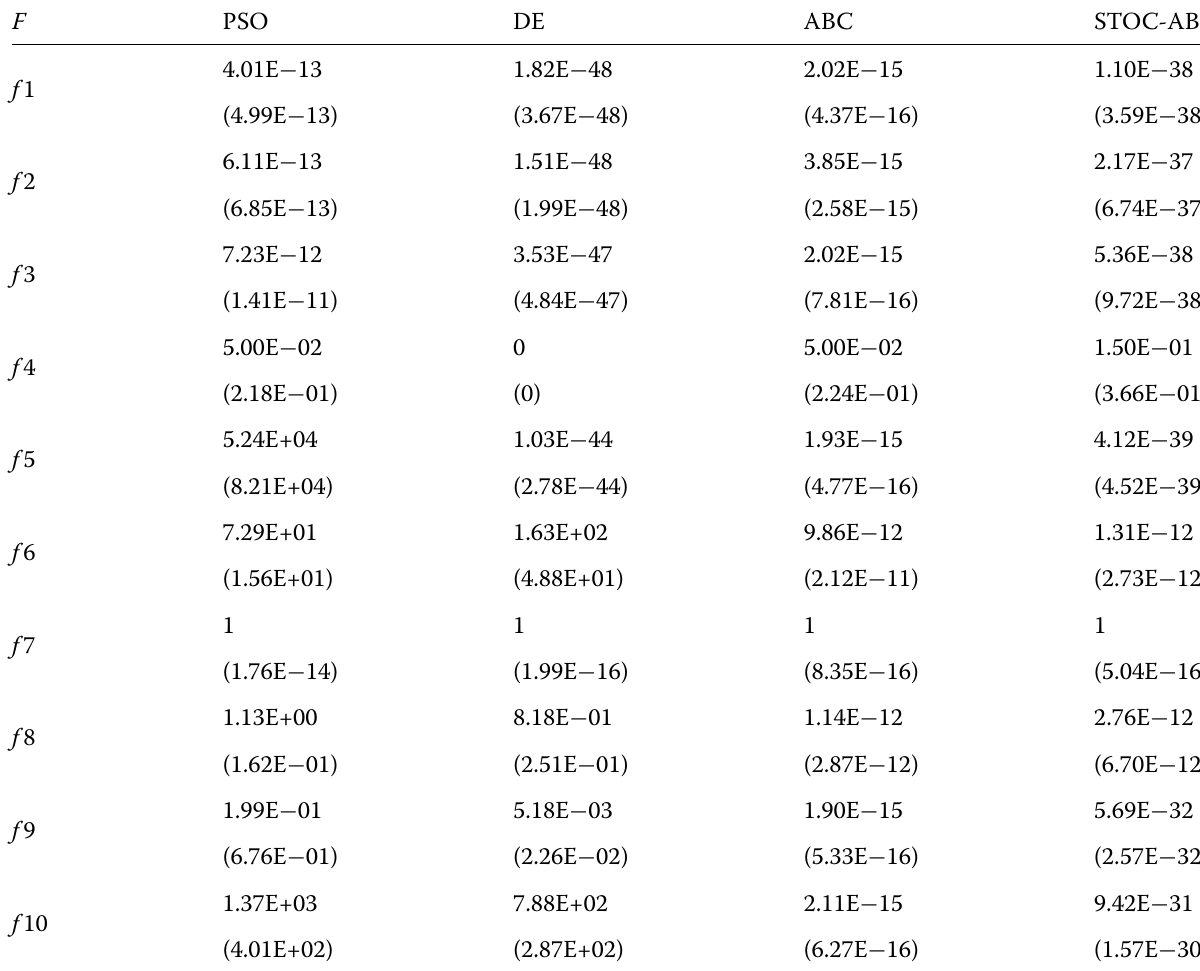
Table 7 Comparison results (1), D =